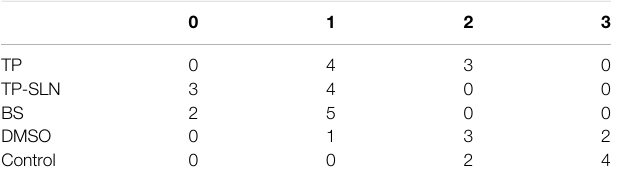
TABLE 1 | The results of ultrasonography in the synovium of knee joint on the 35th day. 0